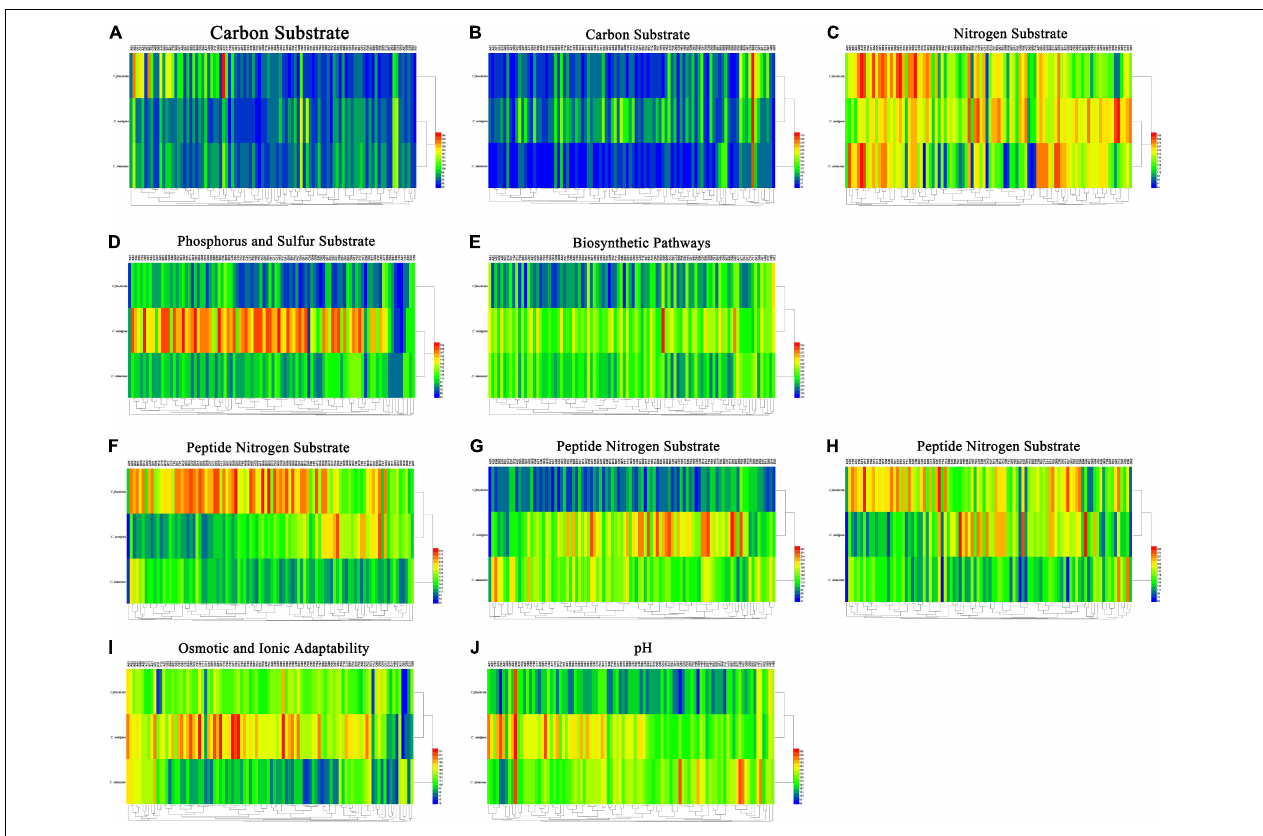
FIGURE 5 | (A) Carbon substrate. (B) Carbon substrate. (C) Nitrogen substrate. (D) Phosphorus and sulfur substrate. (E) Biosynthetic pathways. (F) Peptide nitrogen substrate. (G) Peptide nitrogen substrate. (H) Peptide nitrogen substrate. (I) Osmotic and ionic adaptability. (J) pH. Overview of metabolic phenotypes of Colletotrichum fructicola , C. siamense , C. aenigma . Heatmap of maximum area values of sources expressed as maximum curve area monitored during 84 h of incubation. The legend of color code from blue to green, and red shades indicate low, moderate, and high utilization of sources, respectively, assessed as arbitrary Omnilog